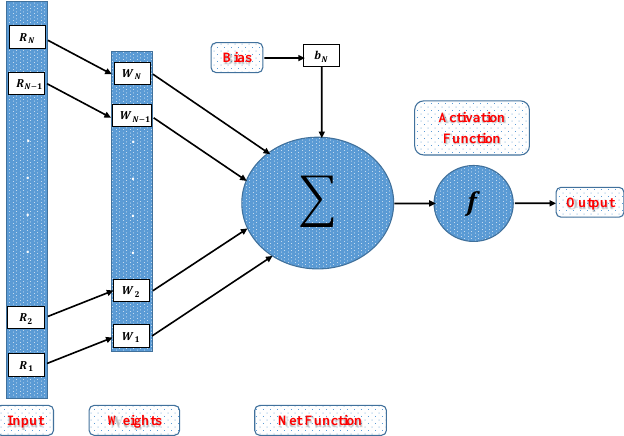
Figure 2. Architecture of single neuron